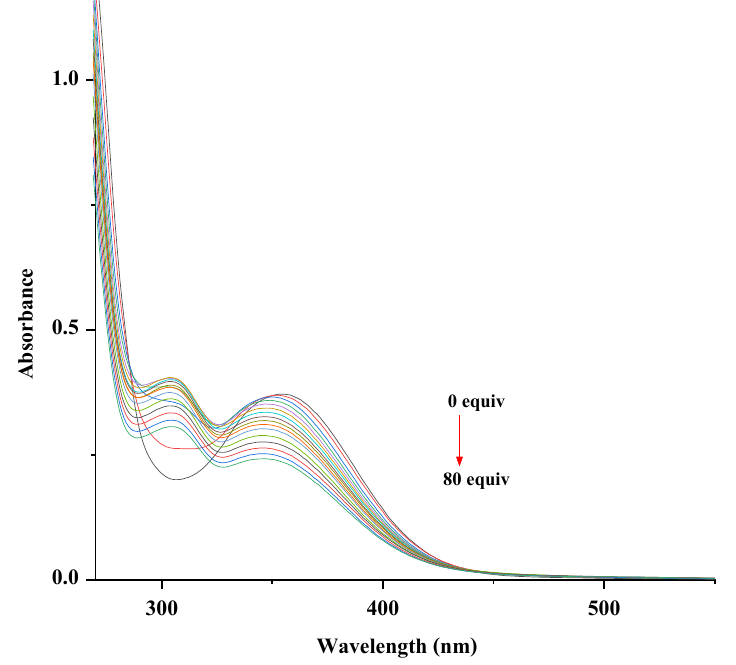
Figure 7. UV-vis spectra of titration between sensor R1 (1 × 10 − 4 M) and fluoride ion in a range of concentrations (0–80 equivalents) in DMSO.